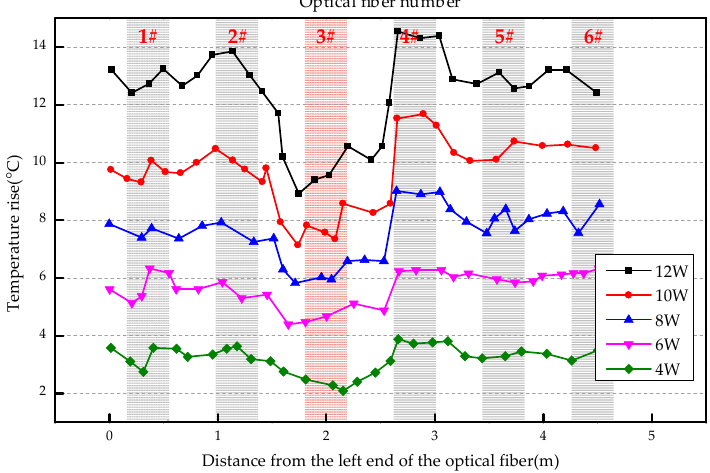
Figure 12. Temperature increase curve of seepage flow velocity at 250 mm/h.